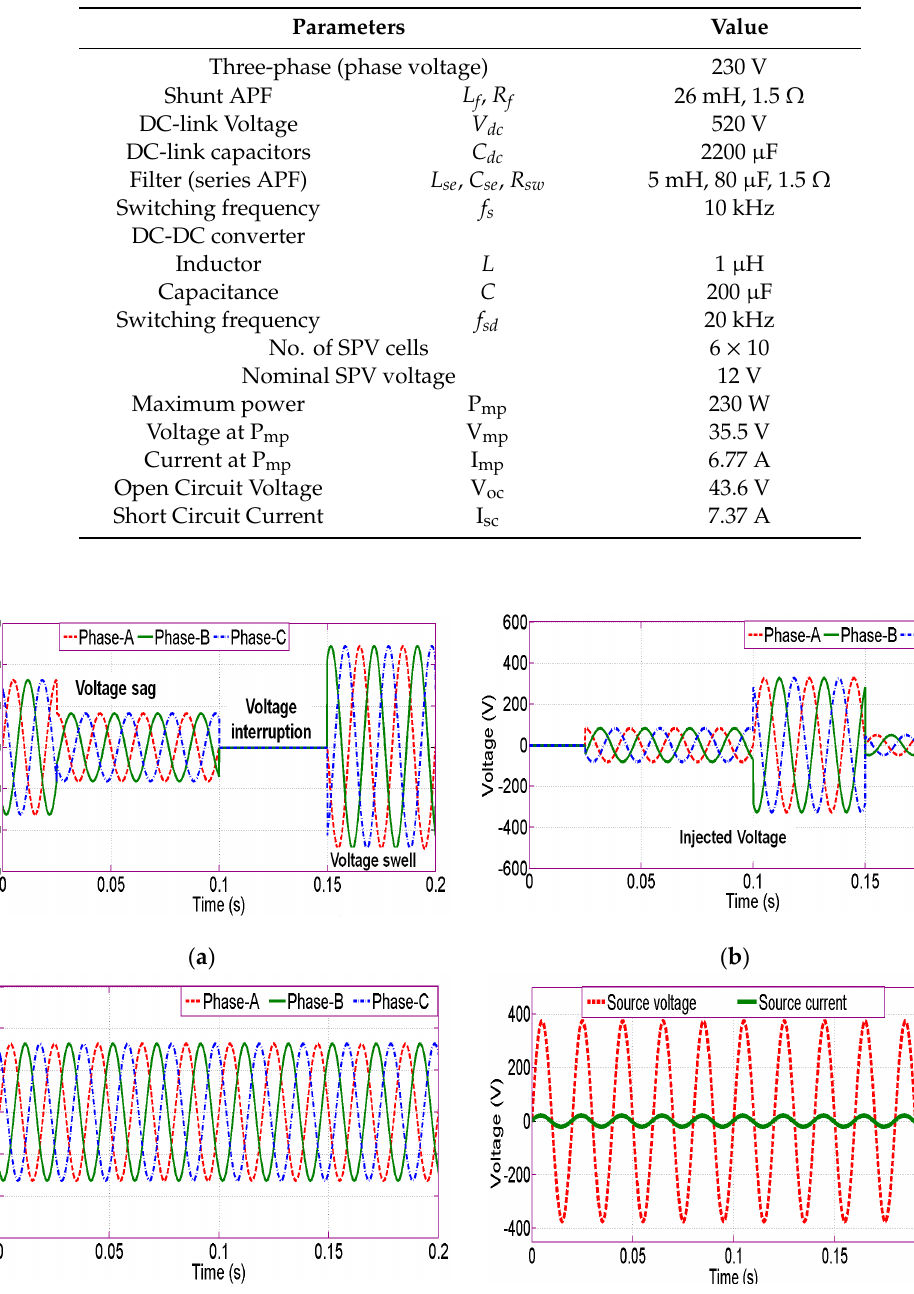
Table 1. Solar photovoltaic-based unified power quality conditioner system parameters.